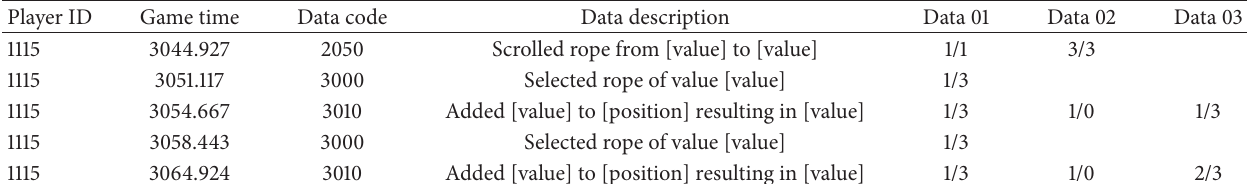
Table 1: Example Save Patch log